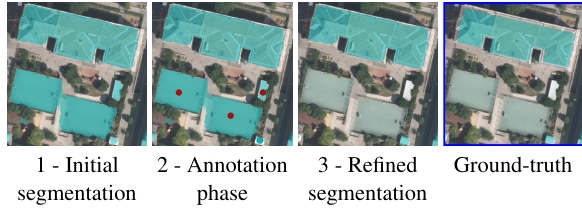
Figure 9. Annotations lead to an easy false positive buildings